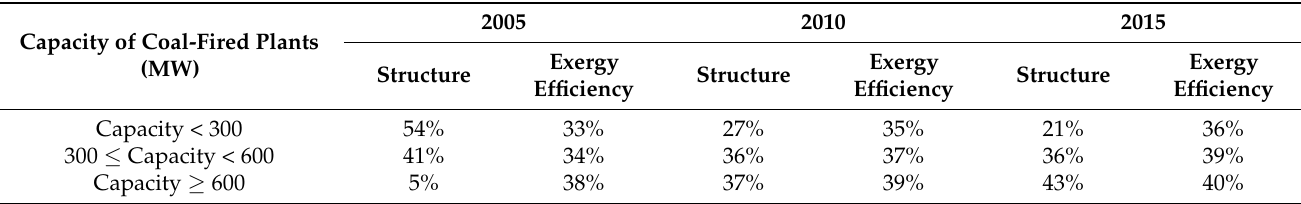
Table A8. Data for the “Dual Structure” of coal-fired power and heat